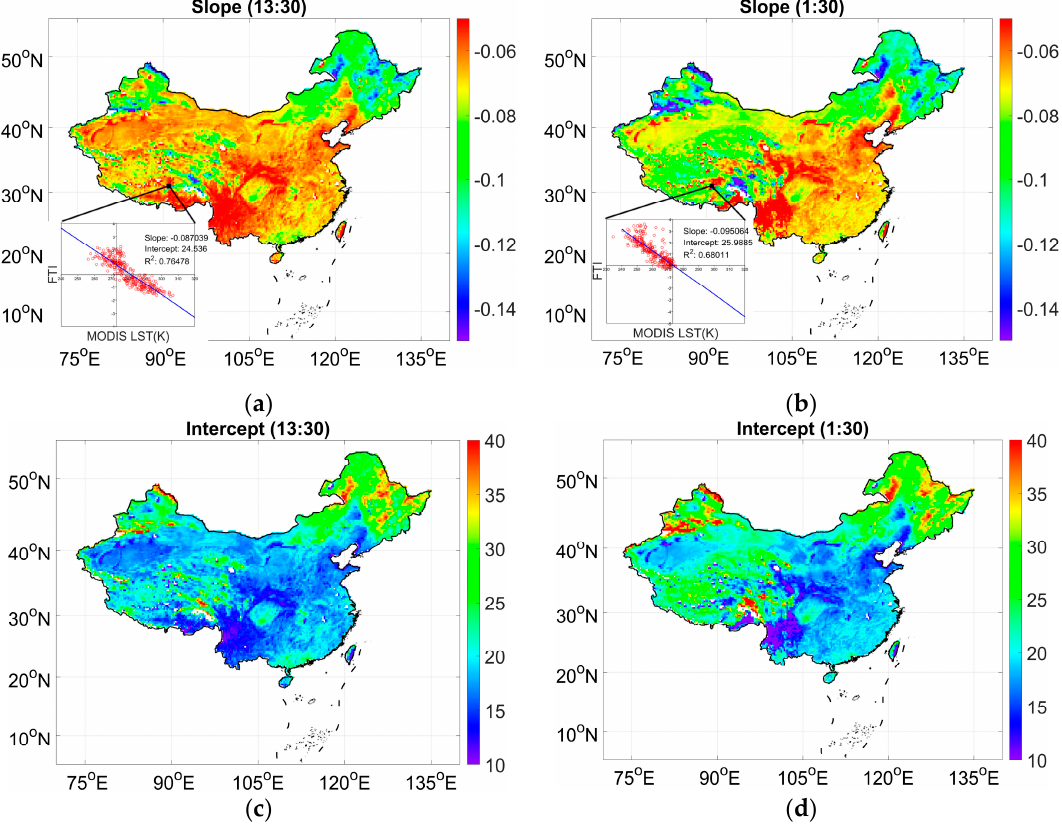
Figure 3. Spatial distribution of parameters “a” and “b” in regression models for observations at 13:30 and 1:30, respectively. ( a , b ) are for “a”; ( c , d ) are for “b”.